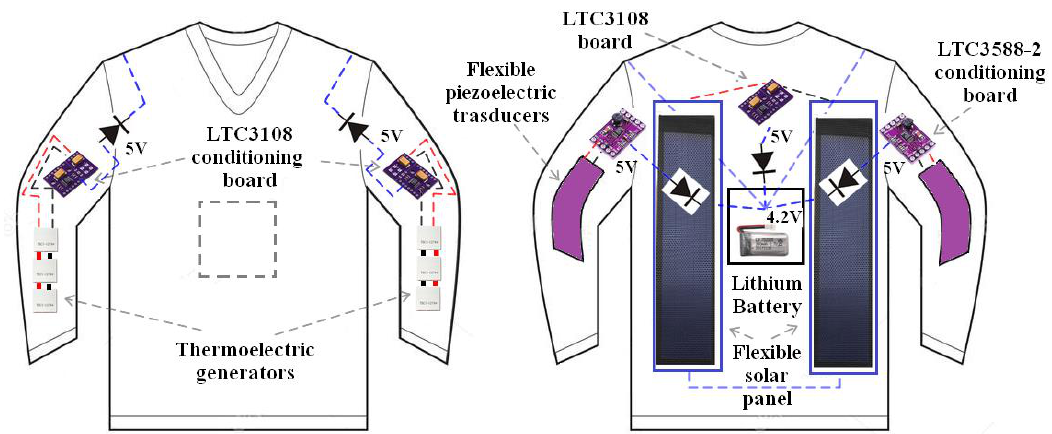
Figure 3. Schematic representation of the multi-source energy harvesting section of the developed smart garment; the electronic conditioning sections related to each energy harvester are shown.